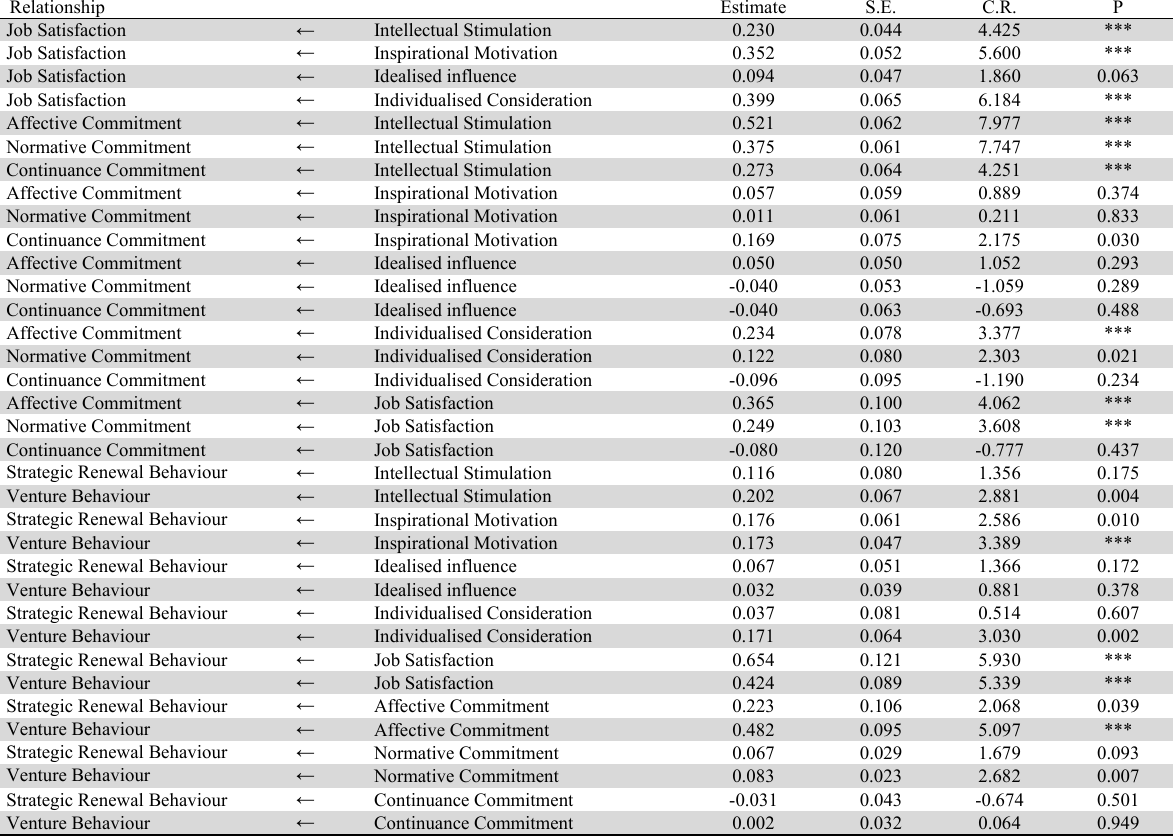
Table 3 Results of testing